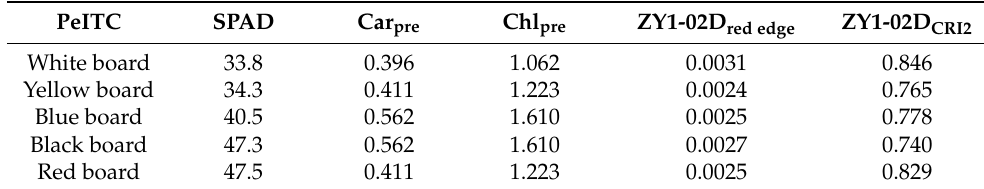
Table 7. Validation table of estimation accuracy.